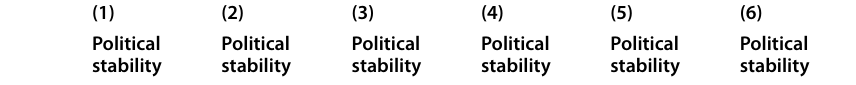
Table 17 Robustness tests: impact of natural disasters on political